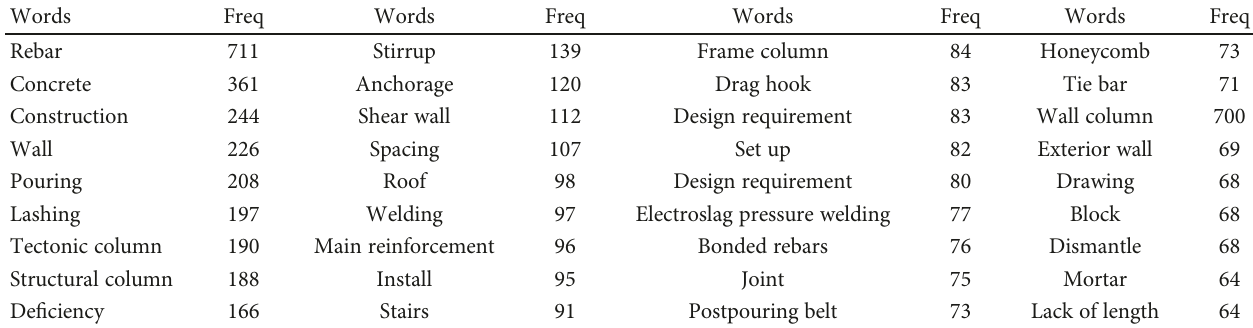
Table 4: The text keyword table of the quality problem of the main body structure.